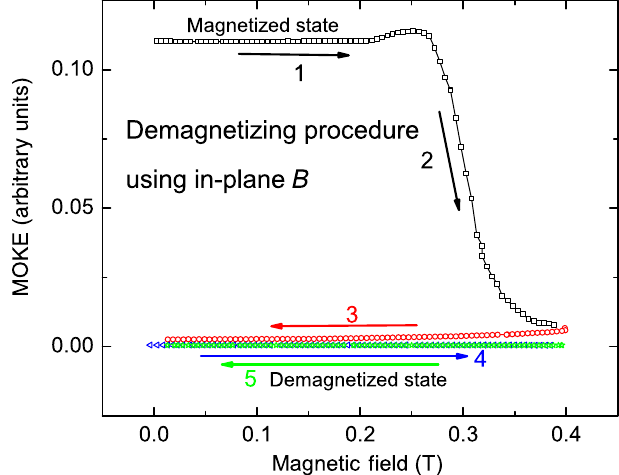
FIG. 9. Magnetization and demagnetization of a ferromagnetic electrode studied with polar MOKE technique. The sample starts in a magnetized state. To demagnetize the sample, we apply an increasing in-plane magnetic field (part 1 of the MOKE loop).